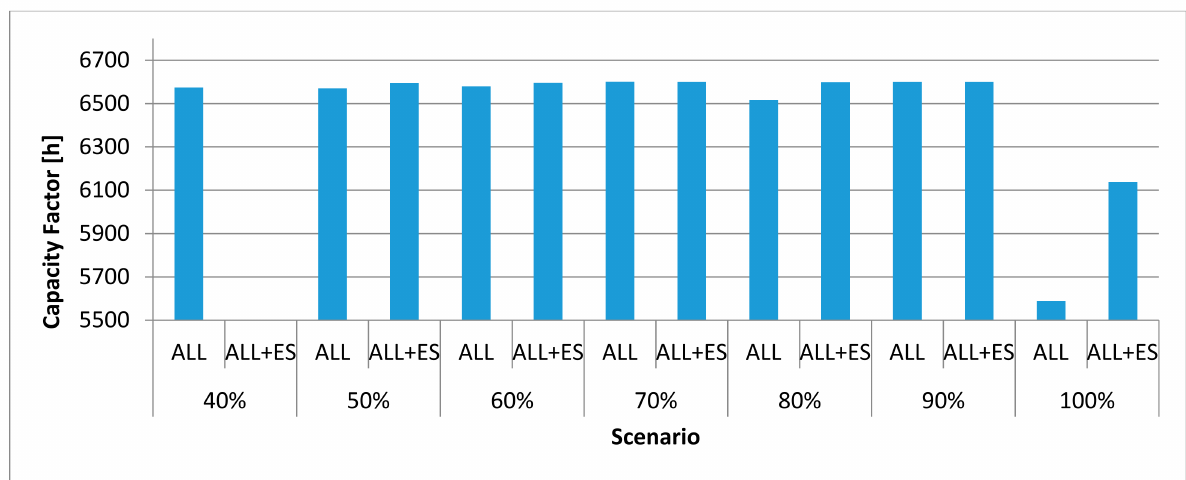
Figure A4. Capacity factor for biogas power